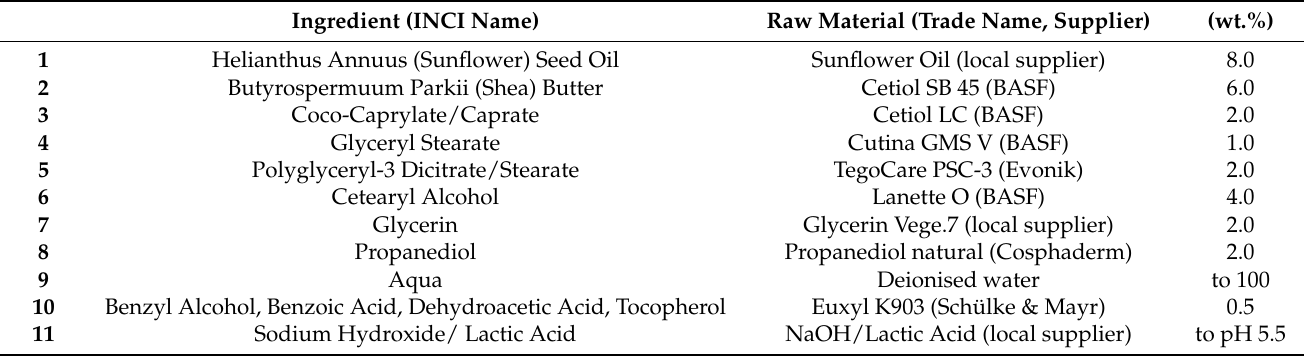
Table 5. Formulation of a model cream for facial skin